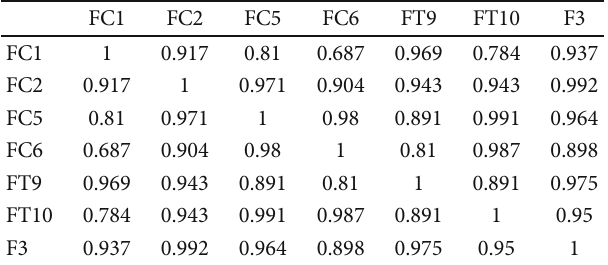
Table 4: Data table for proximity analysis.